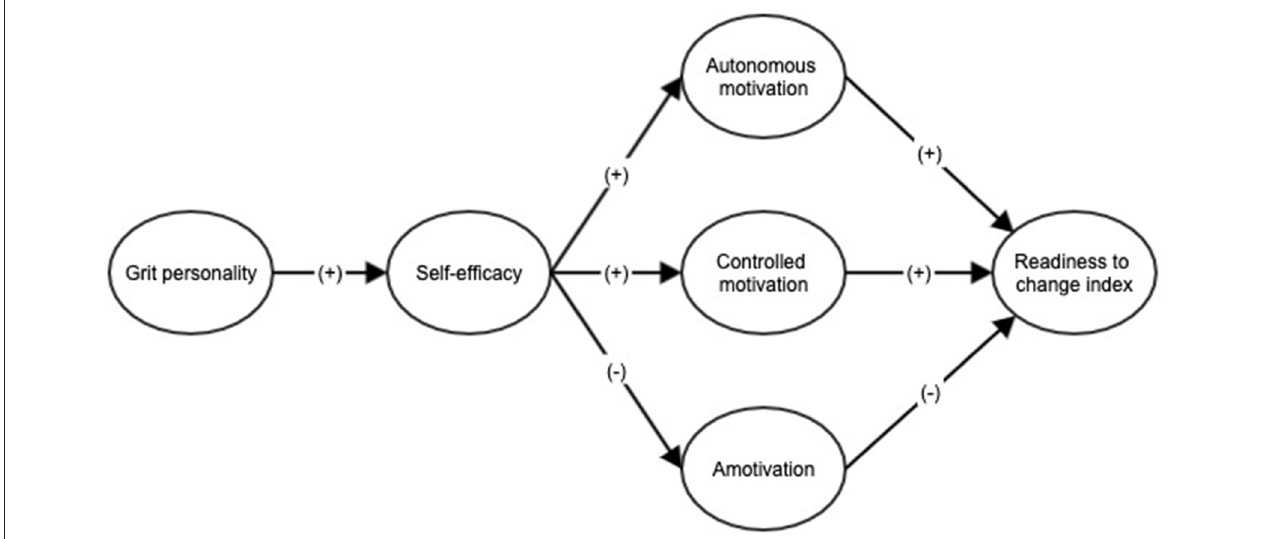
FIGURE 1 | Hypothesized structural equation model of the relationship between grit personality, self-efficacy, motivation (autonomous, controlled, and amotivation) and readiness to change